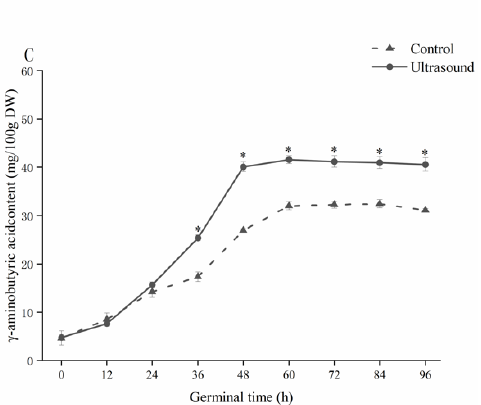
Figure 5. The effect of ultrasonic induction treatment on glutamic acid content ( A ), glutamic acid decarboxylase activity ( B ), and γ –aminobutyric acid content ( C ) during maize germination. * Indicates a significant difference ( p < 0.05) between the ultrasound and control groups.